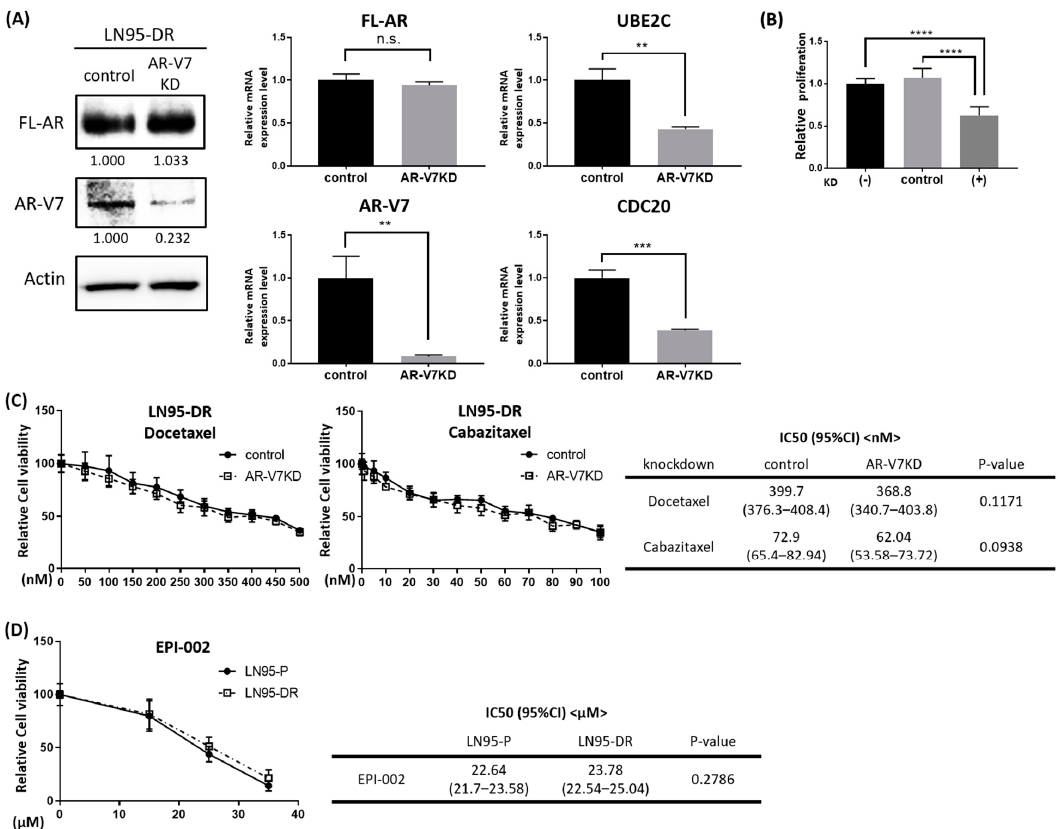
Figure 5. EPI-002 inhibits proliferation of LN95-DR. ( A ) Levels of proteins of FL-AR and AR-V7 and transcripts of FL-AR, AR-V7, UBE2C, and CDC20 in LN95-DR that were transfected with AR-V7 siRNA. After 48 h of transfection with 5 nM AR-V7 siRNA, LN95-DR cells were incubated in serum-free conditions for 48 h prior to collecting the proteins and for 96 h prior to collecting RNA. Transfection with AR-V7 siRNA sufficiently decreased the expression of AR-V7 and the target genes (UBE2C and CDC20) without affecting the level of the FL-AR; ( B ) Knockdown of AR-V7 decreased the proliferation of LN95-DR by 37%. After 48 h of transfection with 5 nM AR-V7 siRNA, LN95-DR cells were incubated in serum-free conditions for 72 h prior to measuring proliferation; ( C ) Dose response curves for docetaxel or cabazitaxel on the viability of LN95-DR cells treated 48 h after transfection with 5 nM AR-V7 siRNA (AR-V7KD). The table shows IC50s of docetaxel and cabazitaxel in LN95-DR cells after knockdown of AR-V7; ( D ) Dose response curve for EPI-002 on proliferation of both LN95-P and LN95-DR cells as measured by the BrdU ELISA assay. The Table shows IC50 values of EPI-002 in LN95-P and LN95-DR cells. n.s.: not significant; ** p < 0.01; *** p < 0.001; **** p < 0.0001.